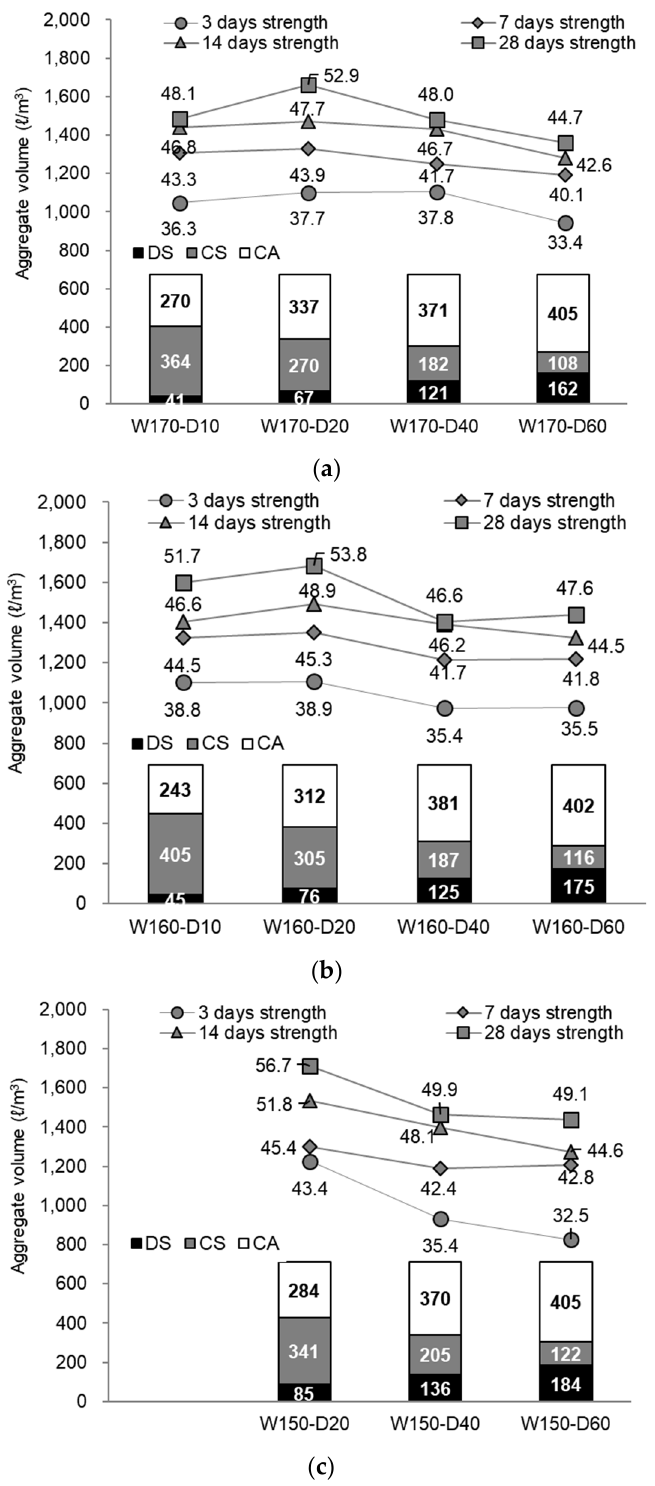
Figure 9. Aggregate volume fractions and compressive strengths of ( a ) W170, ( b ) W160, and ( c ) W150.